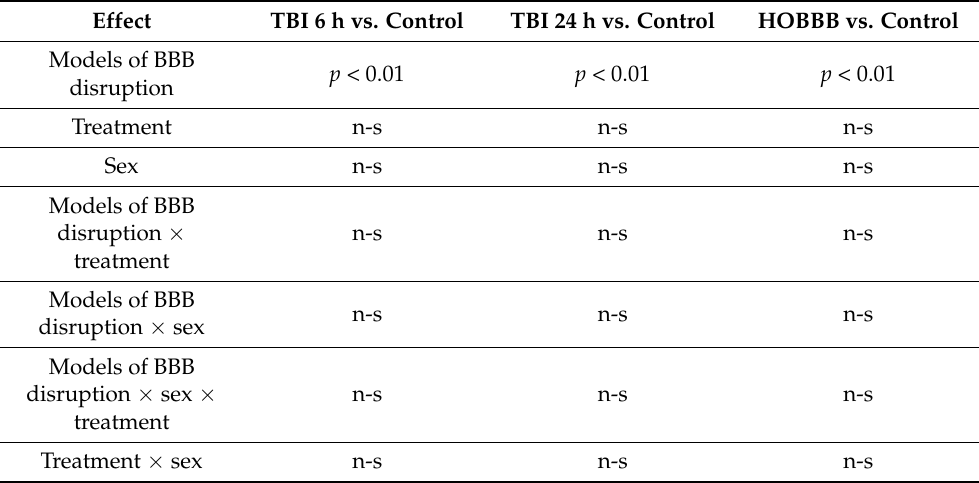
Table 1. Main effects of the model of BBB disruption, treatment and sex and their interaction effects on the Evans blue extravasation index. No significance